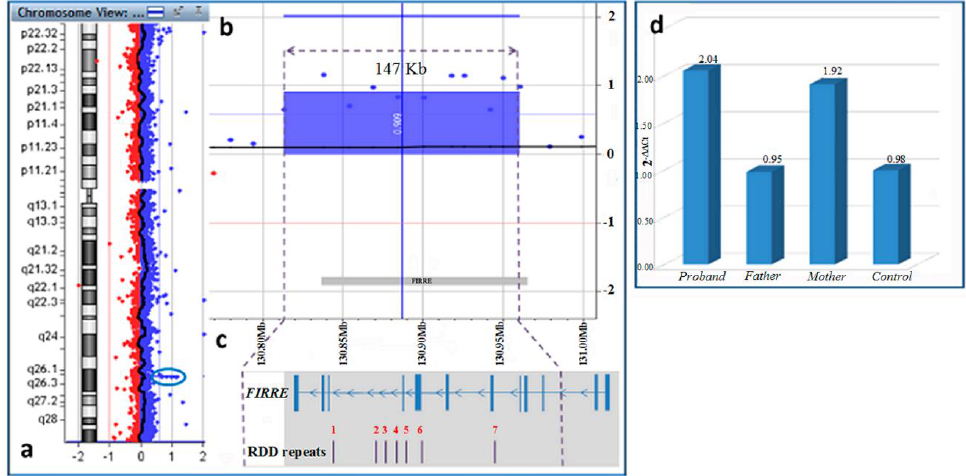
Figure 3. ( a ) genomic profile of chromosome X; ( b ) detailed view of the microduplication of about 147